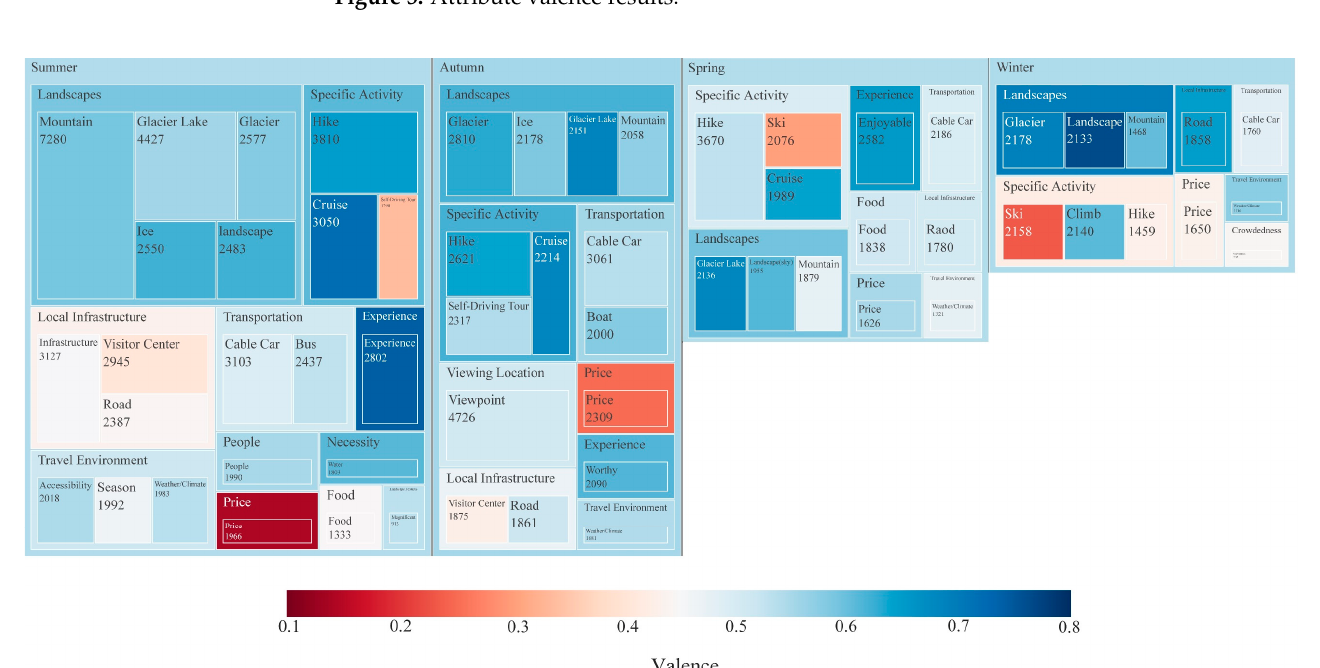
Figure 5. Attribute valence results.